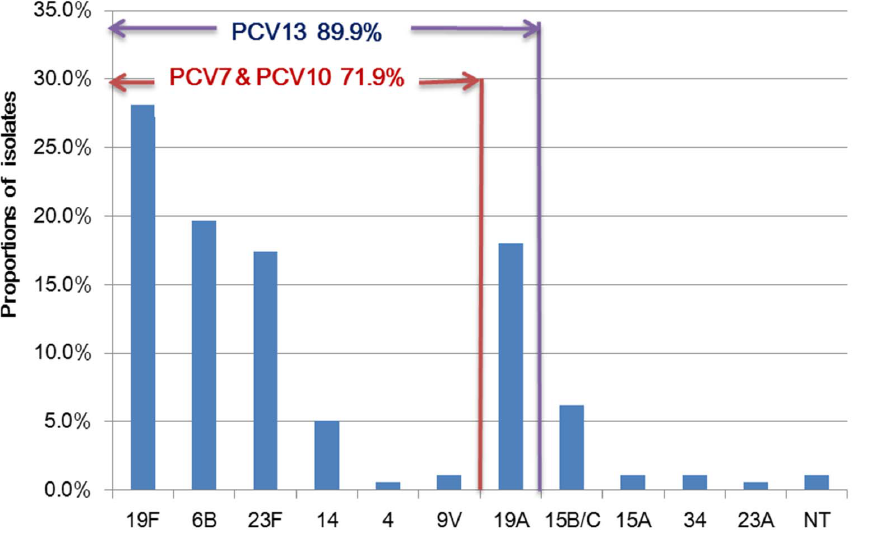
Figure 1. The serotype distribution of the S.pneumoniae isolates. Note: Given to 3 co-colonization isolates, the denominator of PCV coverage rate and serotype proportions was 178. NT indicated non-typed serotypes.